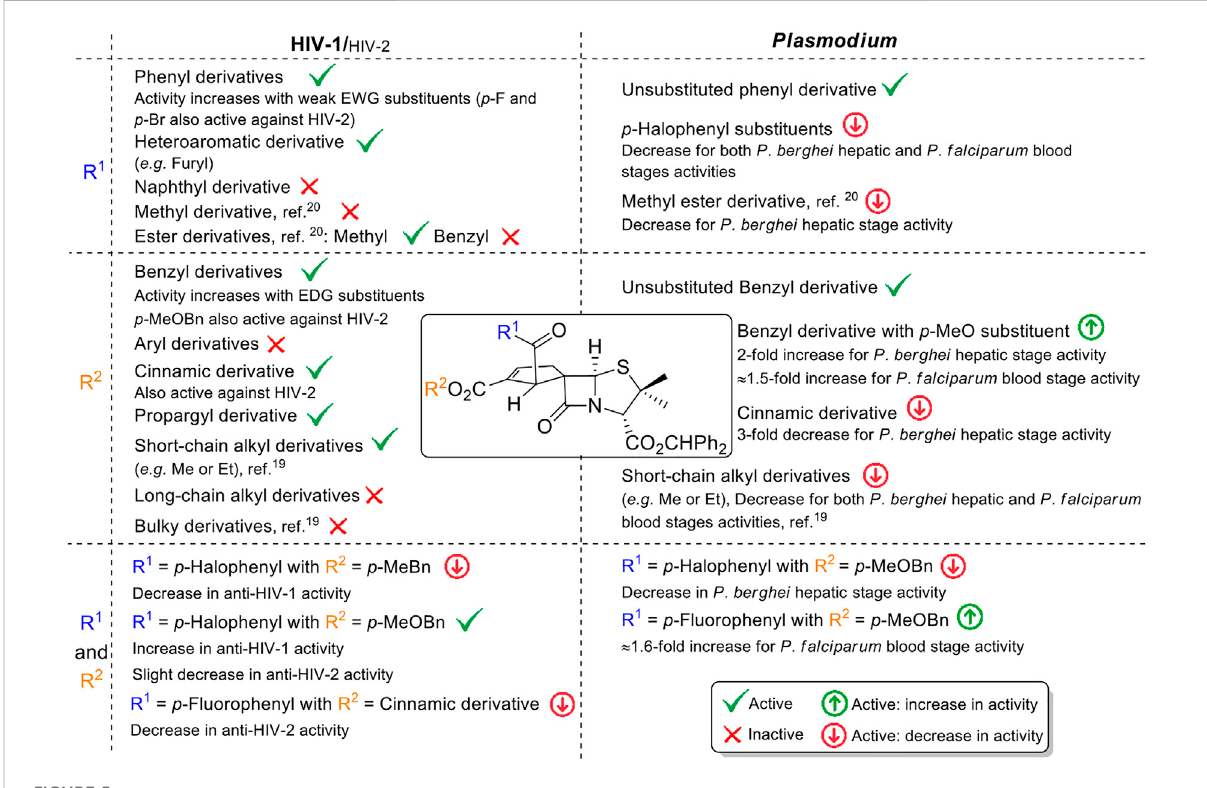
FIGURE 5 Overview of the identi fi ed structure – activity